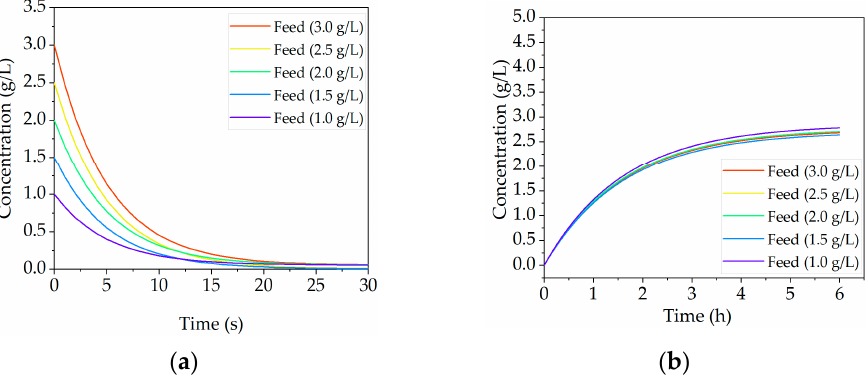
Figure 21. Simulation results of scenario one (concentration fluctuations) are presented for precipitation ( a ) and for dissolution ( b ). These results have shortly been published previously [6].